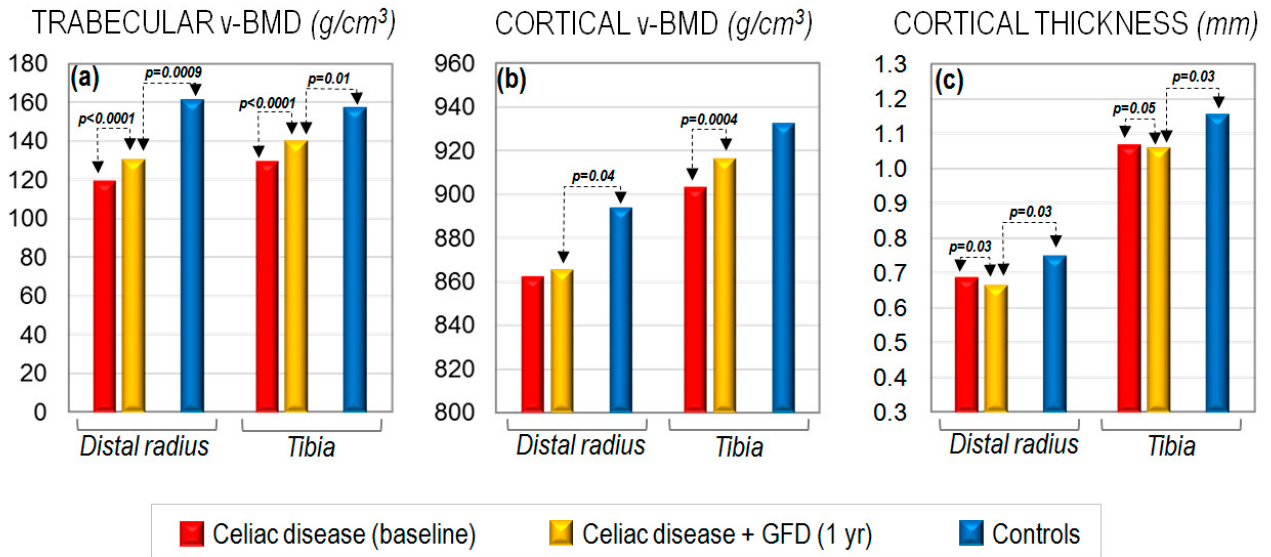
Figure 3. Trabecular ( a ) and cortical ( b ) volumetric BMD changes at the distal radius or tibia and variation of cortical thickness ( c ) assessed with high-resolution peripheral quantitative computed tomography (HRpQCT), before and after 1 year on a gluten-free diet (GFD) in a cohort of premenopausal women with newly diagnosed celiac disease (CD), as compared with healthy females (CTs) of similar age and BMI (derived from Zanchetta MB et al. [86,87]).